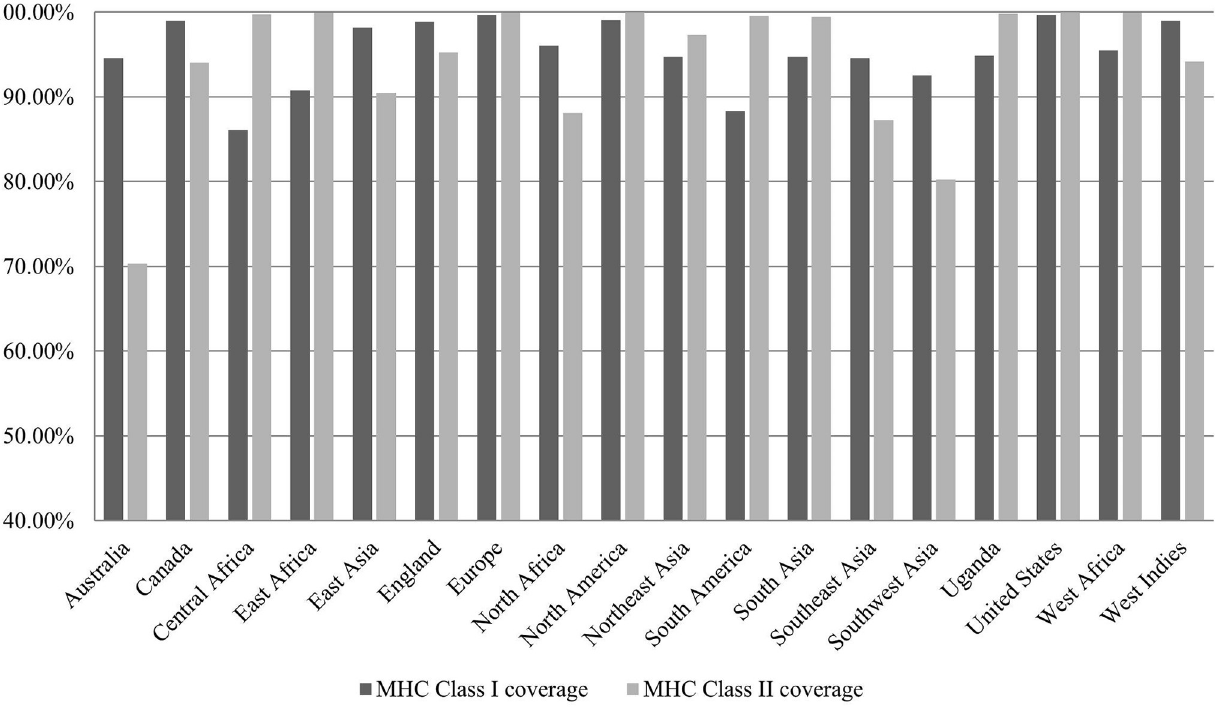
Fig 4. Population coverage analysis of finalized epitopes (MHC-I and MHC-II). Europe, England, North America, United States, and West Africa showed the highest (100%) population coverage.